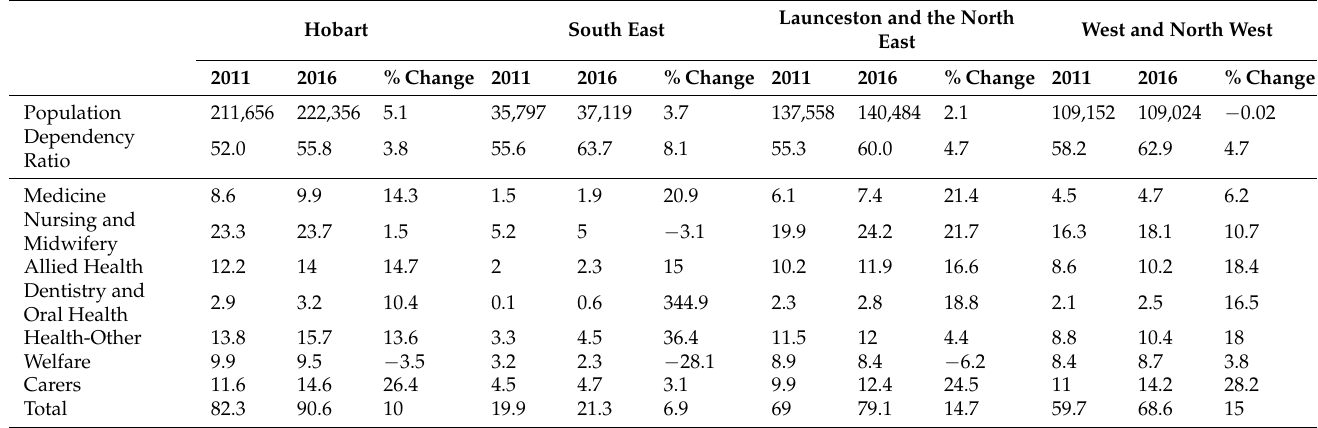
Table 3. Change in annual service hours per capita by